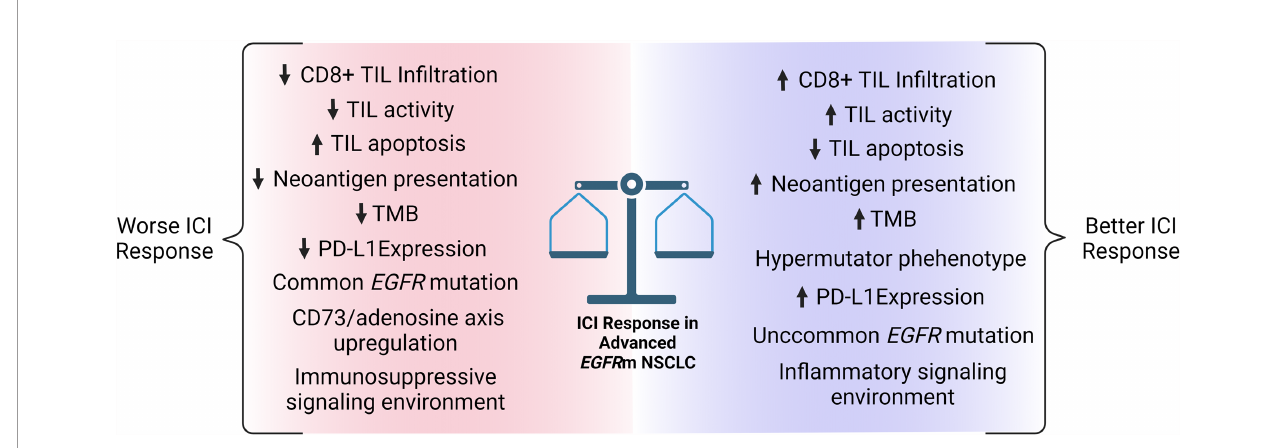
FIGURE 1 | Factors that may in fl uence immune checkpoint inhibitor response in advanced EGFR m NSCLC. ICI, immune checkpoint inhibitor; TIL, tumor in fi ltrating lymphocyte; TMB, tumor mutational burden; PD-L1, programmed cell death 1 ligand. Figure created with